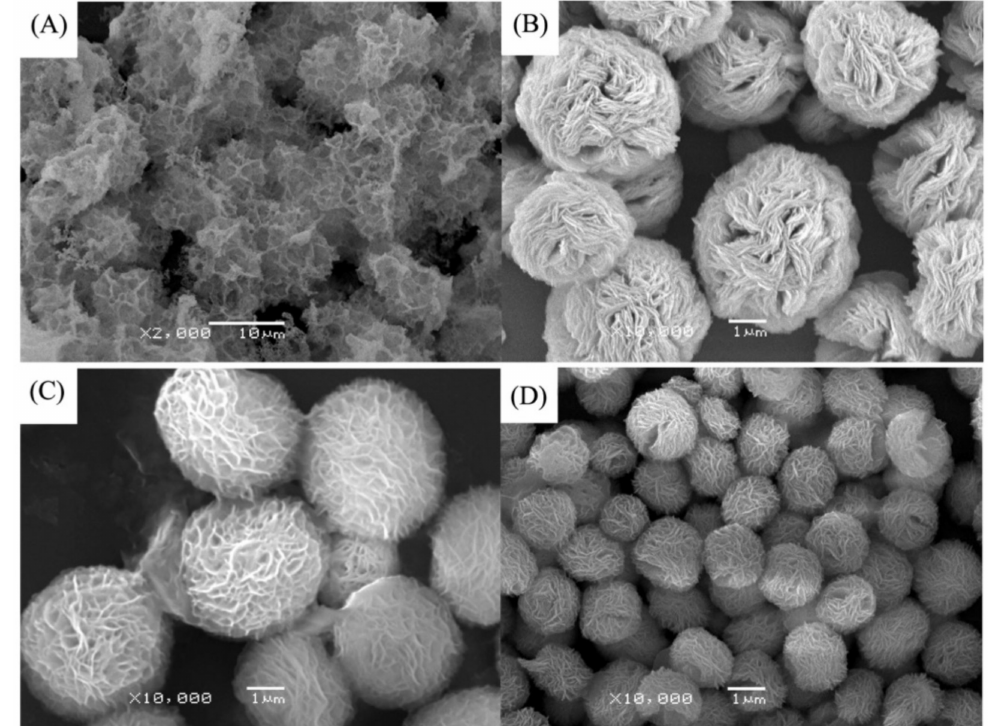
Figure 6. SEM image of different soybean peroxidase (SBP) concentrations on the formation of nanoflowers: ( A ) 0.0 mg/mL, ( B ) 0.5 mg/mL, ( C ) 1.0 mg/mL, and ( D ) 2.0 mg. Reprinted from